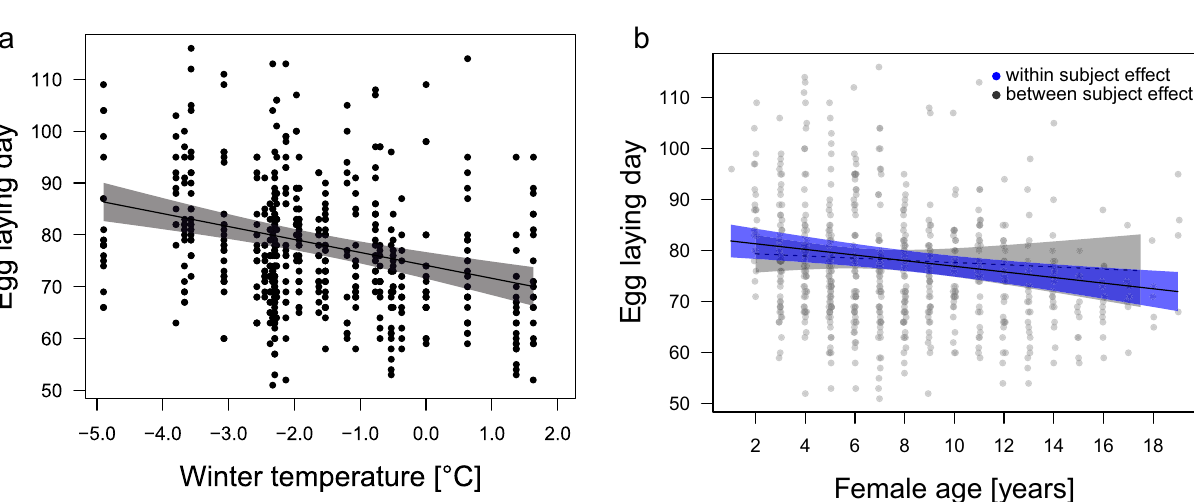
Figure 4. Relationship between breeding phenology and ( a ) winter temperature and ( b ) female age. Higher winter temperatures (Dec–Feb) are associated with an earlier onset of breeding (estimate − 0.33 ± 0.06, − 0.452 LCI − 0.202 UCI) and older females lay earlier than younger females (within individual effect: estimate − 0.13 ± 0.04, − 0.217 LCI − 0.054 UCI; between individual effect: estimate − 0.19 ± 0.06, − 0.309 LCI − 0.064 UCI) in greylag geese in the Alm valley, Austria, between 1990 and 2018. Lines are the predicted relationships based on the output of the LMM (Table 2), with 95% CIs in shaded grey. Background scatter represents raw data (n = 614 breeding records of 155 individual females over 29